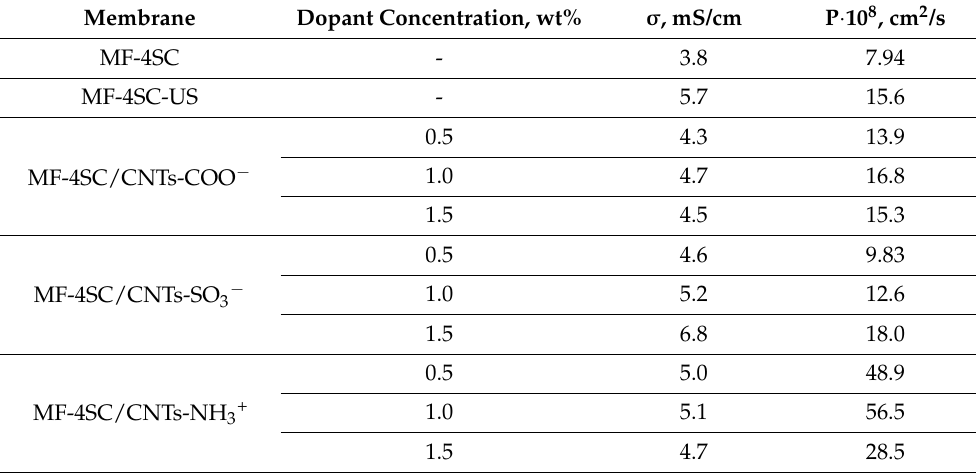
Table 2. The ionic conductivity ( σ , mS/cm) in contact with water at 30 ◦ C and diffusion permeability (P, cm 2 /s) in 0.02–0.5 M KCl solution of the membranes in the K + -form (the relative errors in the estimation of conductivity and diffusion permeability are below 10 and